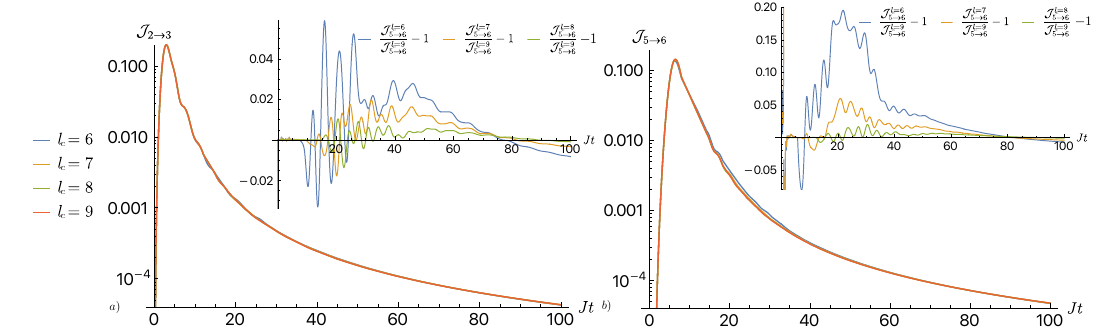
Figure 8: a) The information-current → 3 with the relative error as inset (using J 2 = 9 as reference). b) The equivalent plot the largest truncation value l c information-current → l + 1 shows good convergence as long as l c J l par with the convergence of the other observables we